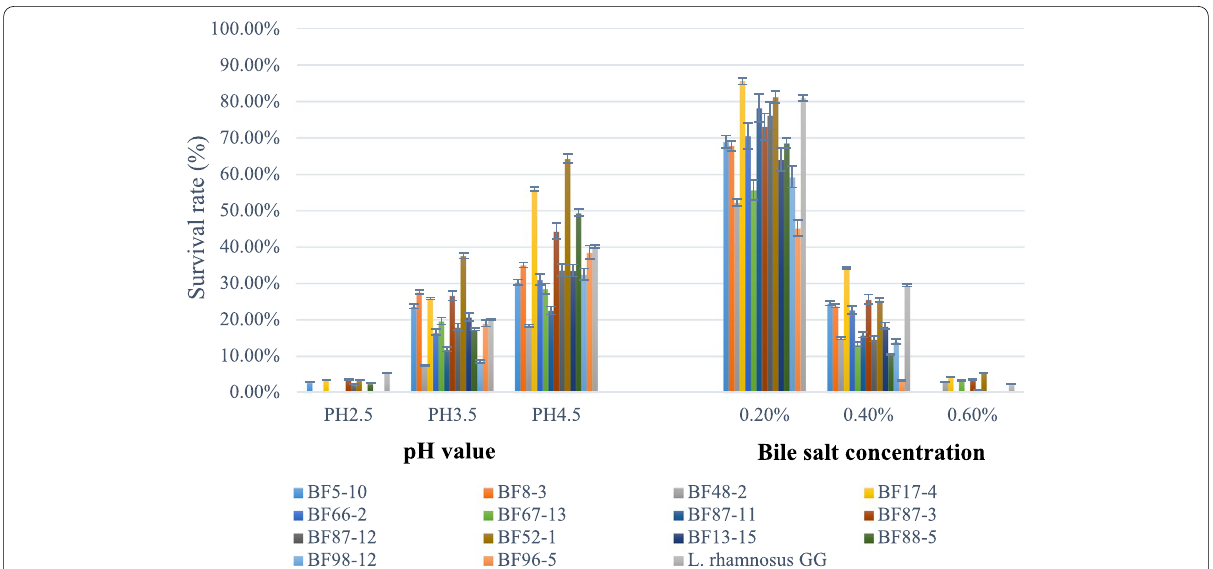
Fig. 1 Survival rate (%) of the Bifidobacterium strains in low pH and bile salts. (Error bars indicate standard deviation from three independent